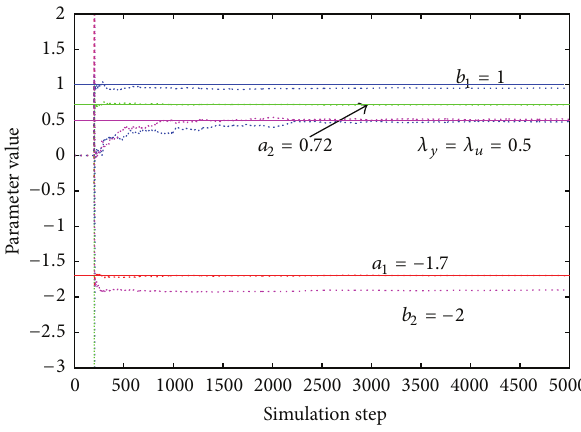
Figure 2: Estimation result of 𝜃 in System 1.